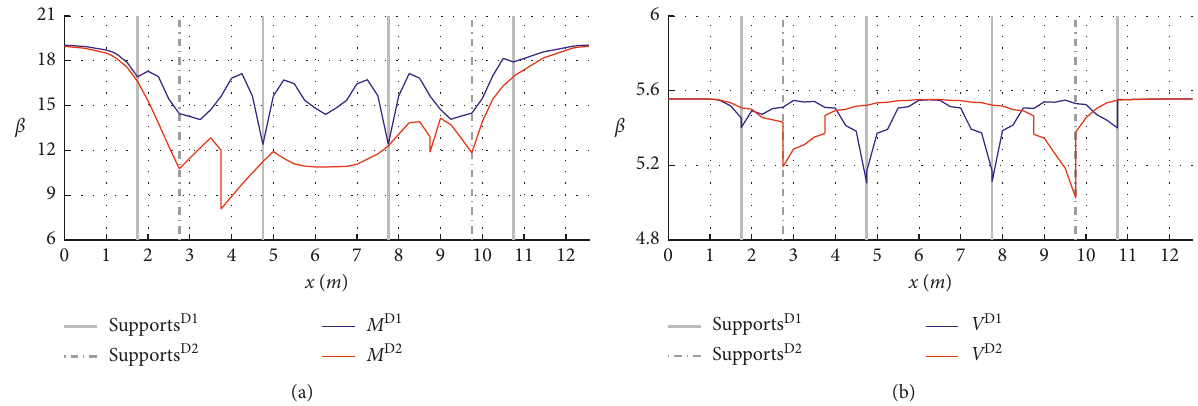
Figure 10: Reliability index β for the deck in the two design alternatives: related to the bending limit state (a) and to the shear limit state